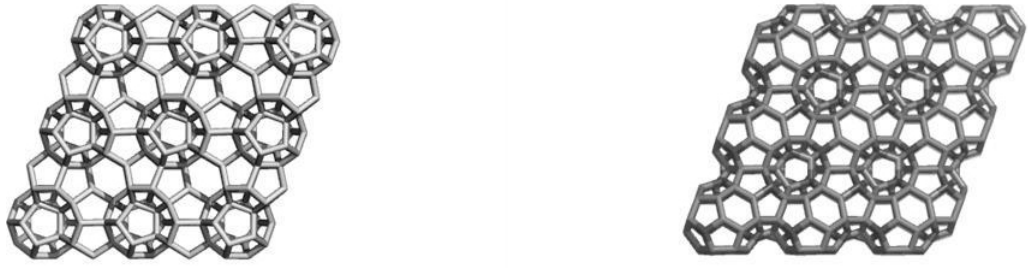
Figure 1. Diamond D